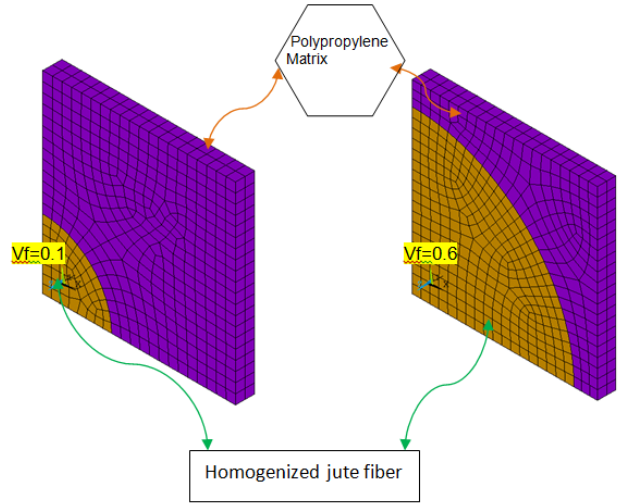
Figure 9. Finite element models of jute fiber reinforced polypropylene.